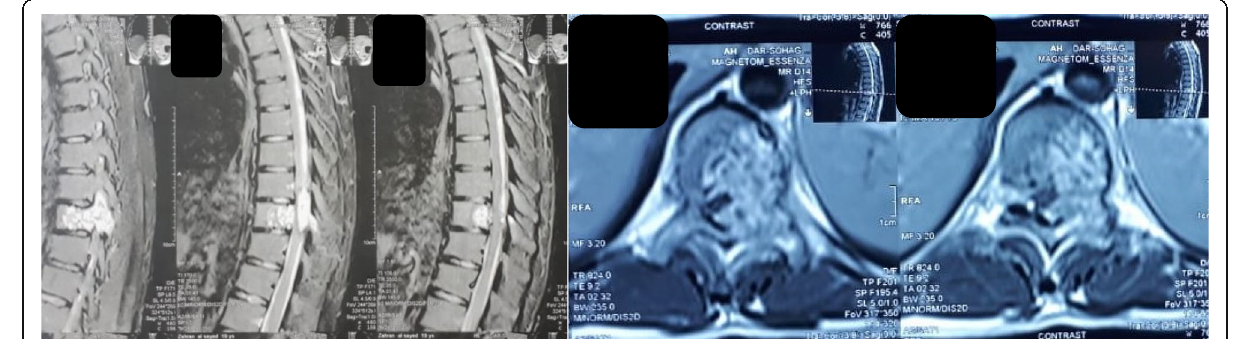
Fig. 8 MRI of the dorsal spine showing the effect of dorsal 10